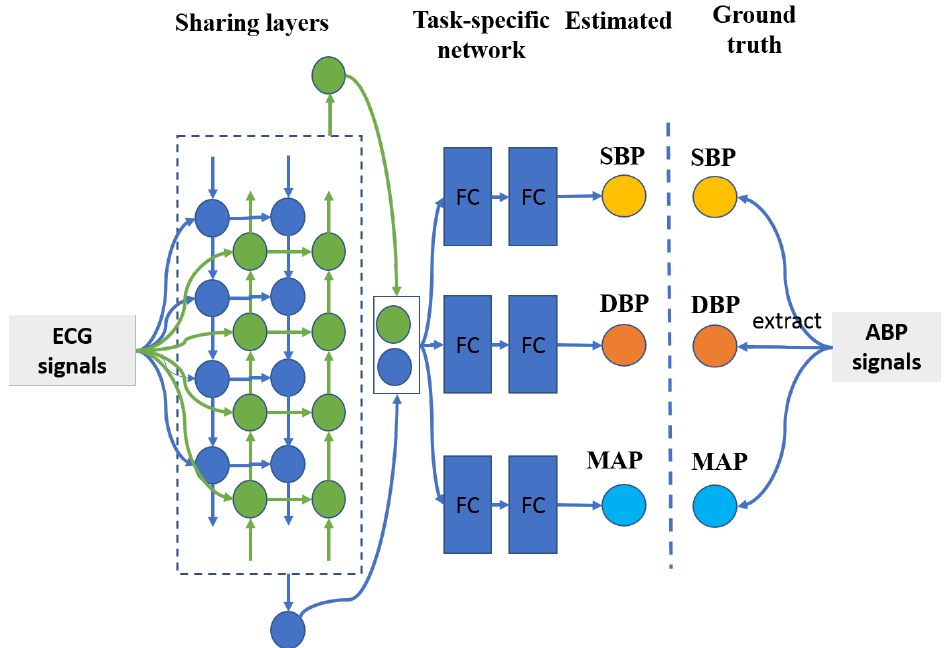
Figure 3. The architecture of the proposed method. It was composed of sharing layers and task- specific networks. FC means fully connected